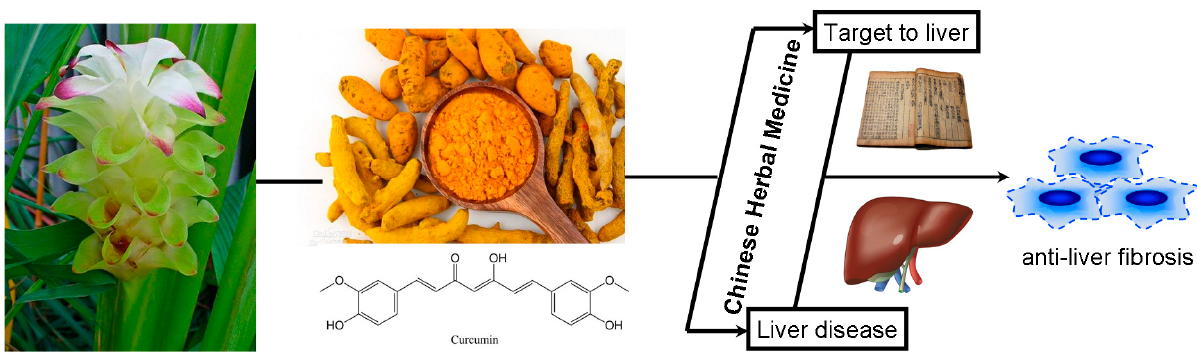
Figure 1. Overview of our study.